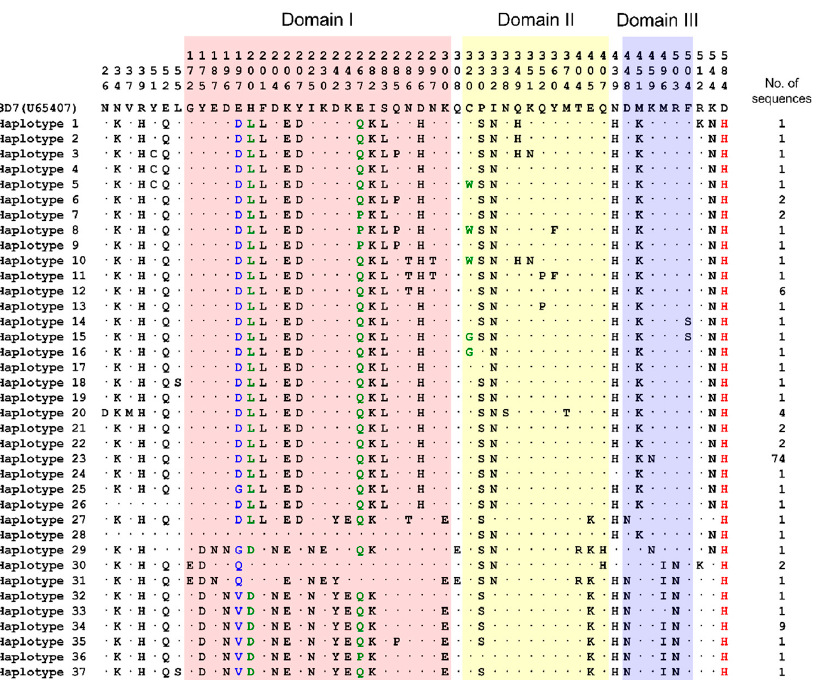
Figure 2. Amino acid sequence polymorphisms in the Vietnamese pfama-1 . A total of 131 pfama-1 sequences were obtained from 135 Vietnamese P. falciparum isolates. Sequence analysis of the se- quences revealed that 64 non-synonymous SNPs were detected in Vietnamese pfama-1 ; resulting amino acid changes at 52 positions compared to pfama-1 of 3D7 (GenBank Accession No: U65407). Most amino acid changes were identified in domains I, II, and III. Identical amino acid residues with 3D7 sequences were indicated by dots. Based on these amino acid polymorphisms, Vietnamese pfama-1 classified into 37 distinct haplotypes. These amino acid changes were unevenly scattered in each Vietnamese pfama-1 haplotype. However, few amino acid changes were commonly identified in Vietnamese pfama-1 with high frequencies. Conserved amino acid change identified in all Vietnamese pfama-1 are marked as red. Tri-morphic amino acid changes (H200D/L, E267P/Q, and C320G/W) are presented as green. Penta-morphic amino acid changes (E197D/G/Q/V) are marked as blue. Domains I, II, and III are highlighted as shading with different colors, red, yellow, and blue, respectively.